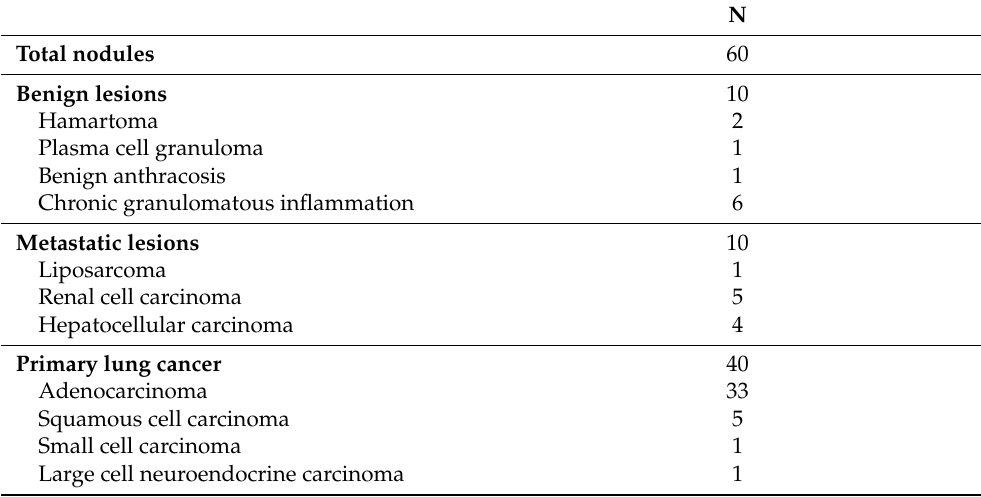
Table 4. Pathologic